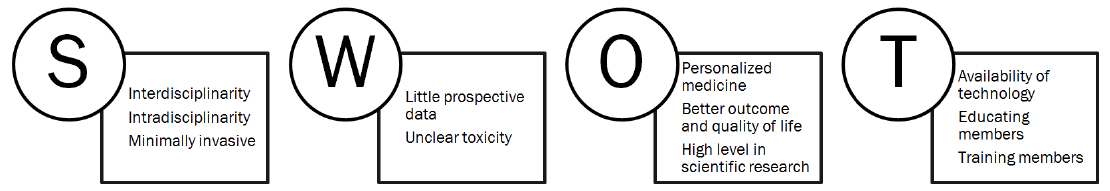
Figure 5. Swot analysis of nanotechnology in the treatment of oral cavity carcinoma.